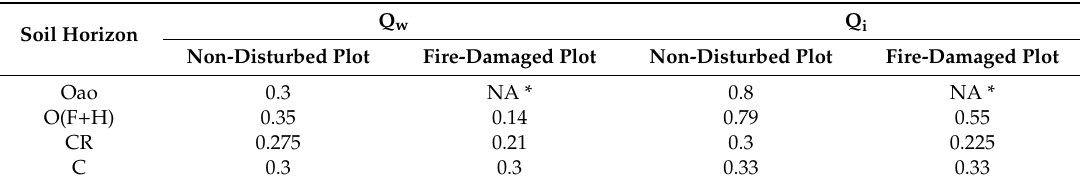
Table 2. Volumetric water content (Q w ) in summer and ice content (Q i ) in winter for soil with non-homogenous water content (NHS), summarized from [45,51]. Soil